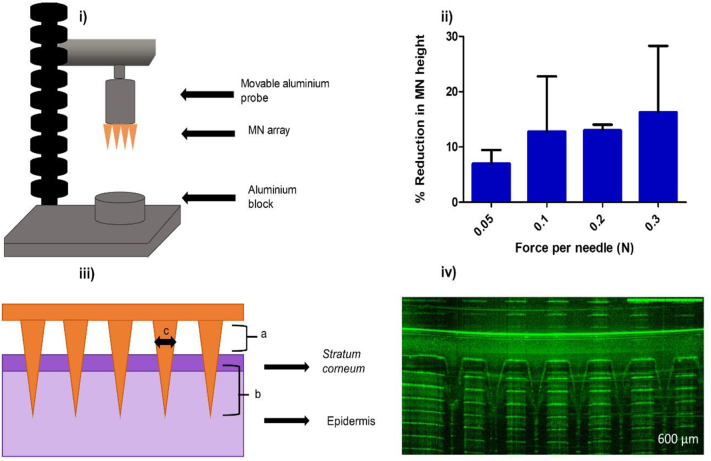
(i) Measuring the mechanical strength of MNs using the Texture Analyser (TA). (ii) Representative bar chart of percentage reduction in the height of needles of MNs measured following the application of different forces using the Texture Analyser (means ± SD, n = 3). (iii) Diagrammatic representation of the measurements that are possible from the optical coherence tomographic images of MN penetration into skin, namely; a, the distance between the lower MN base plate and the stratum corneum (SC); b, the depth of MN penetration into the skin; and c, the width of the micropore created.(iv) The insertion of MNs array in Parafilm® M using OCT.